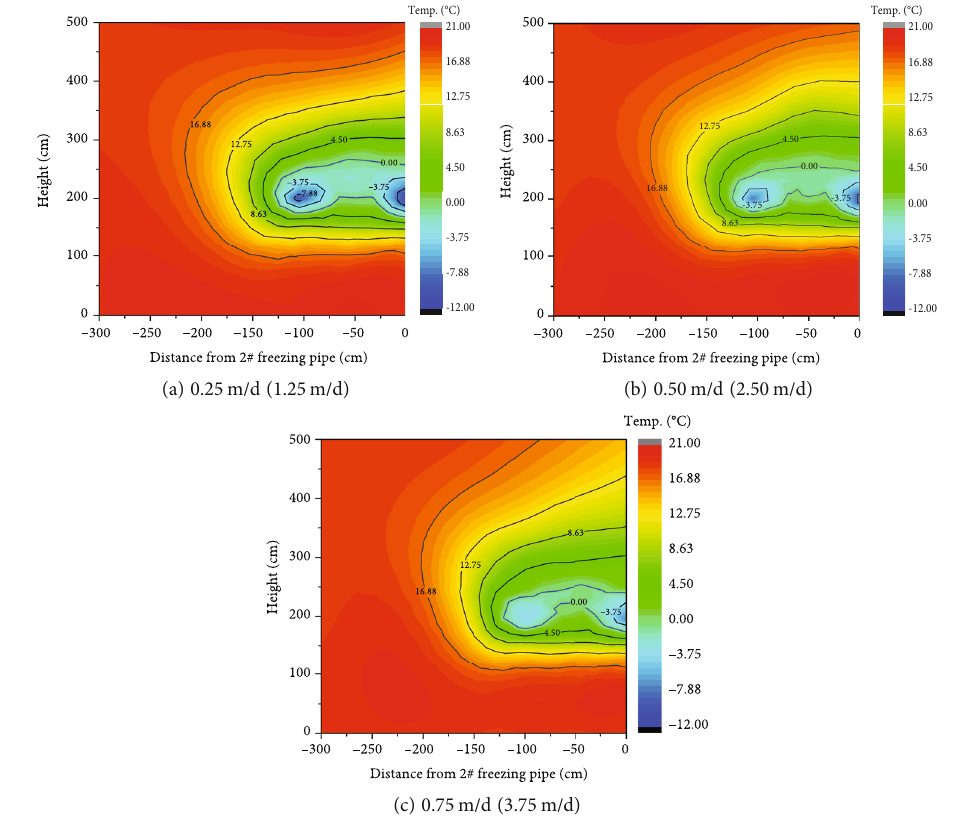
Figure 1: Temperature fi eld at closure time of frozen wall. Table 3: Di ff erences between results from the numerical and physical model. Frozen